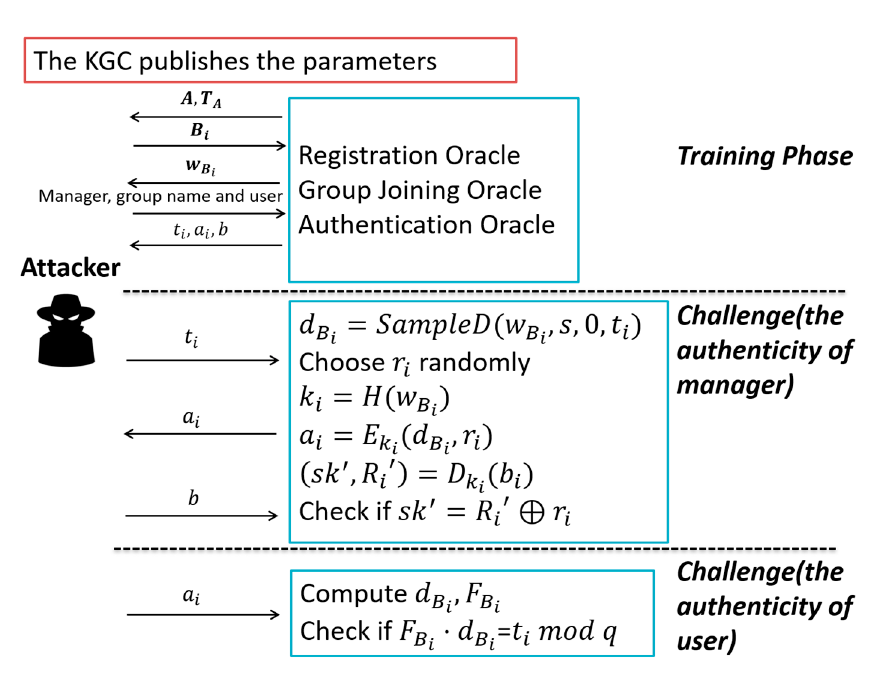
Figure A1. The security model of group mutual authentication.